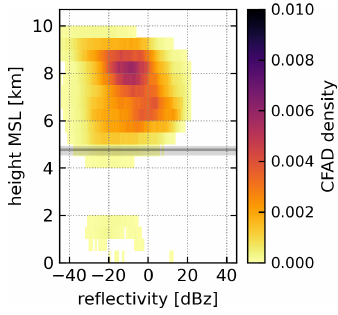
Figure 16. CFAD from HALO cloud radar for 15 February at 21:50–23:30UTC. Horizontal gray bar and line indicate height range and mean value of the 0 ◦ C isotherm on that